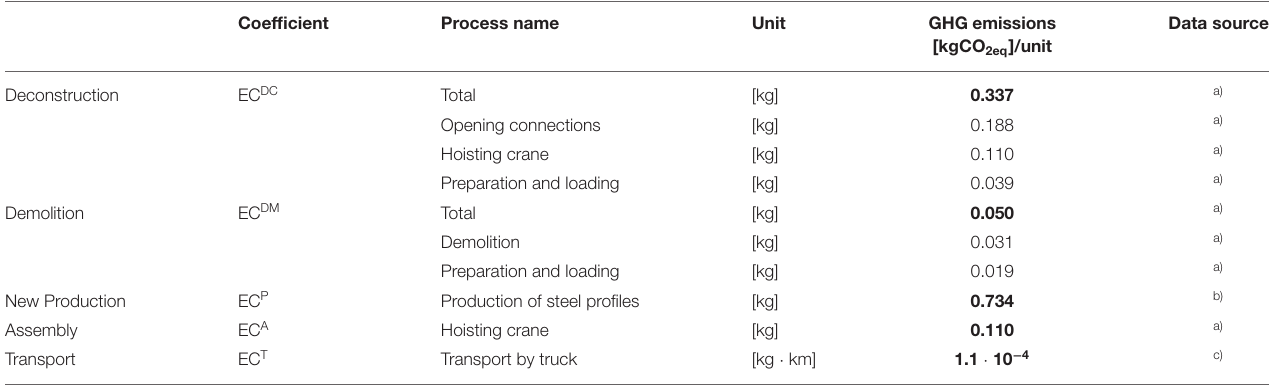
TABLE 1 | Embodied GHG emission